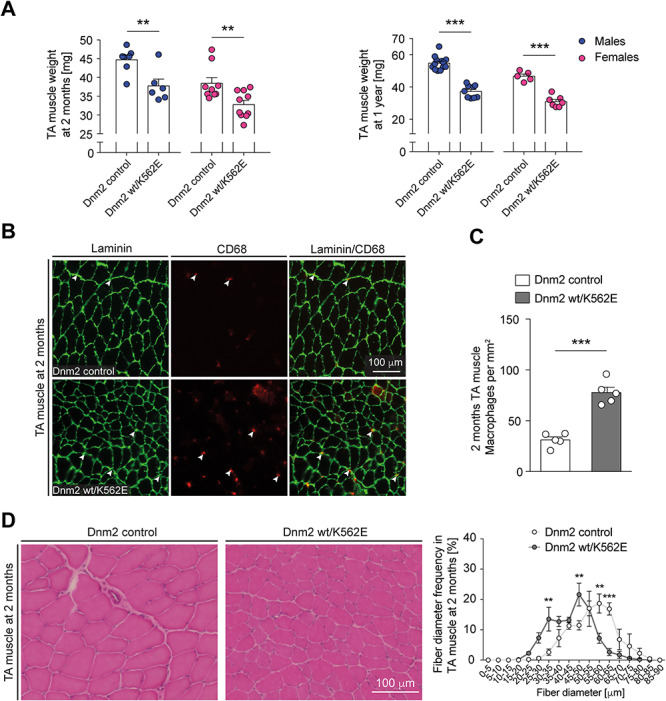
The myopathic features in Dnm2 wt/K562E mice are not restricted to the soleus muscle. (A) Weight analysis of the TA of control and Dnm2 wt/K562E sex-specific mice at 2 months and 1 year of age. The muscles have a lower mass in Dnm2 wt/K562E males and females compared to sex-specific controls at both ages. Bar heights, mean; error bars, SEM (females at 2 months, n = 9 control and n = 10 Dnm2 wt/K562E; females at 1 year, n = 5 control and n = 7 Dnm2 wt/K562E; males at 2 months, n = 7 control and n = 6 Dnm2 wt/K562E; males at 1 year, n = 13 control and n = 9 Dnm2 wt/K562E). (B) Exemplary cryosections of TAs derived from 2-month-old control and Dnm2 wt/K562E mice, probed with antibodies against laminin or CD68. Exemplary CD68-positive macrophages (white arrowheads) are highlighted. Scale bar: 100 μm, refers to whole panel. (C) Quantification of CD68-positive macrophages in between myofibres reveals a significant enrichment in Dnm2 wt/K562E TAs at 2 months. Bar heights, mean; error bars, SEM (n = 5 mice/genotype, images of three sections quantified and averaged per mouse). (D) (Left) Exemplary H&E-stained TA cryosections derived from control and Dnm2 wt/K562E mice at 2 months. Scale bar: 100 μm, refers to whole panel. (D) (Right) Quantification of myofibre diameter frequencies shows a shift towards smaller-calibre myofibers in Dnm2 wt/K562E TA at 2 months. Datapoints, mean; error bars, SEM (n = 4 mice/genotype, images from three sections quantified and averaged per mouse). Two-tailed unpaired Student’s t-test (A, C) and two-way ANOVA with Sidak’s multiple comparisons test (D). Significance was set at **P < 0.01 and ***P < 0.001.